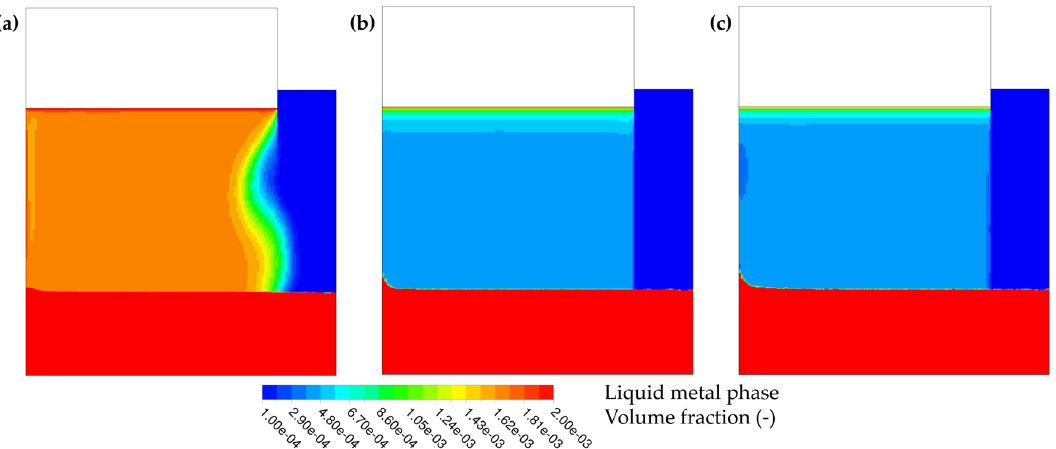
Figure 9. Liquid metal volume fraction (time-averaged) considering the fall of 1 mm ( a ), 5 mm ( b ) and 10 mm ( c ) liquid metal 10 mm ( c ) liquid metal drops.